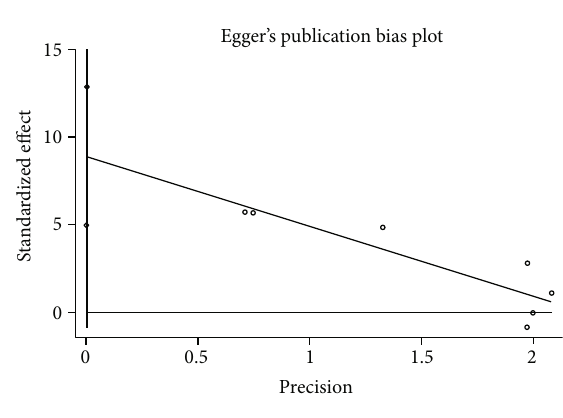
Figure 8: Publication bias of DHI.